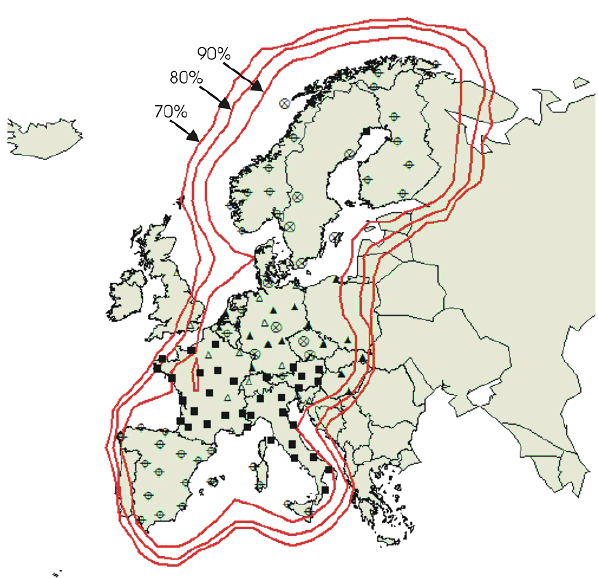
Fig. 1. Projected Flash Detection Efficiency for the EUCLID Net- work (Network status October 2005) for peak currents greater than